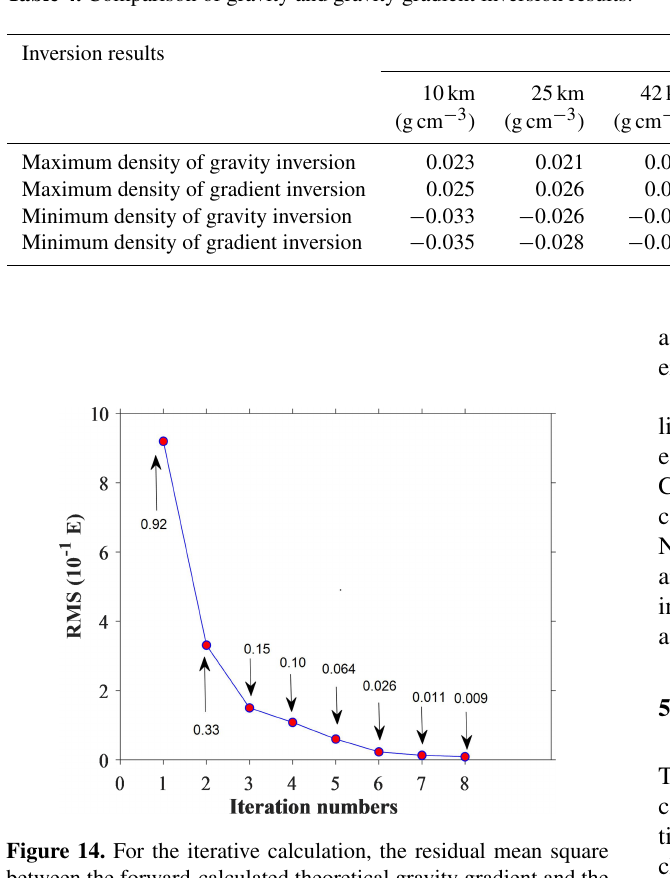
Table 4. Comparison of gravity and gravity gradient inversion results.